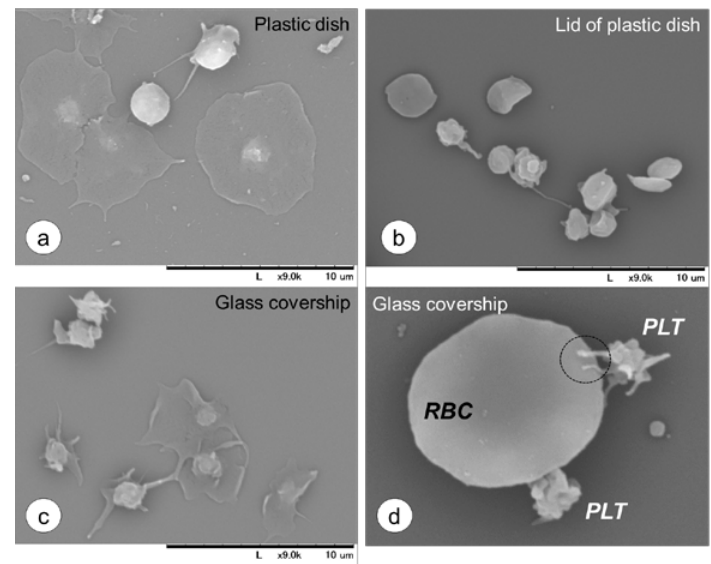
Figure 6. SEM observations of platelets on cell culture wares in the absence or the presence of RBCs. Washed platelets suspended in Hepes–Tyrode solution were placed on plastic dishes ( a ), hydrophobic lids of plastic dishes ( b ) or glass coverslips ( c ) and incubated for 10 min at 37 °C. As above, RBC-contaminated platelet suspensions were plated on the coverslip and incubated (d). Data is representative of three independent experiments. Bar = 10 μm.